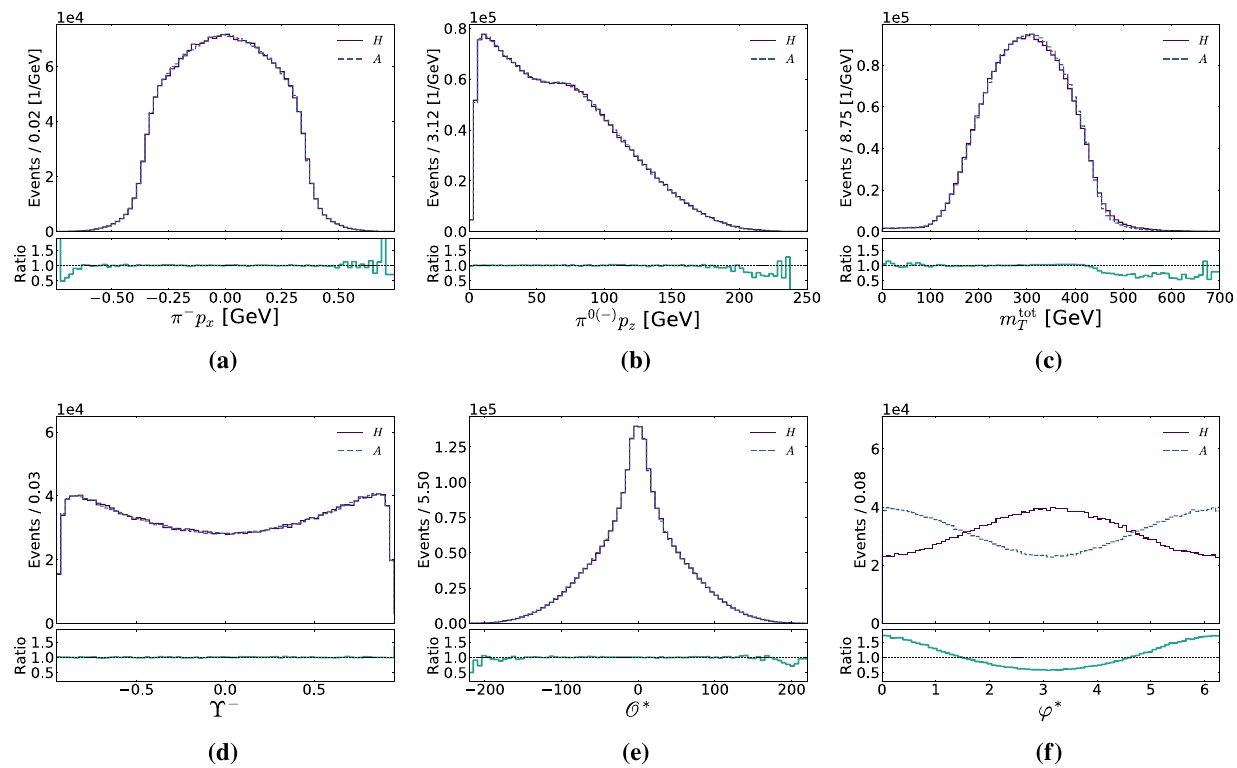
Fig. 1 Distributions for some kinematic features in H → ττ → (π + π 0 ν)(π − π 0 ν) events (solid purple line) and A → ττ → (π + π 0 ν)(π − π 0 ν) events (dashed blue line), assuming m 450GeV. The quantities in a and b are momentum components of the π − and π 0 from the τ − decay, after each event has been boosted back to the visible ditau restframe and rotated such that the taus are back-to-